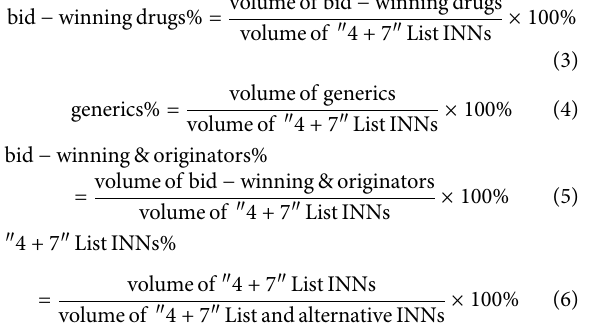
demonstrates no s